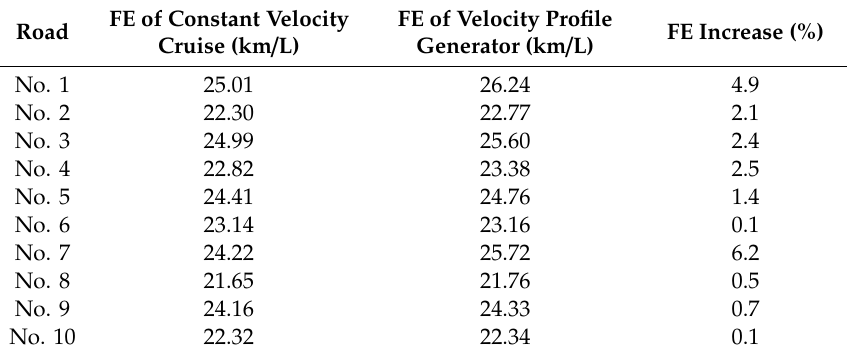
Figure 13. Generalization results in road no. 10. The trip made at the final iteration of total 20 iterations of training. Roads no 1–9 were used in the training whereas road no. 10 was not. All the trips including road no. 10 seems to have a fuel saving velocity profile for the road. The results for roads no 1–9 is shown in Appendix B. Table 5. Comparison between constant velocity cruise and our